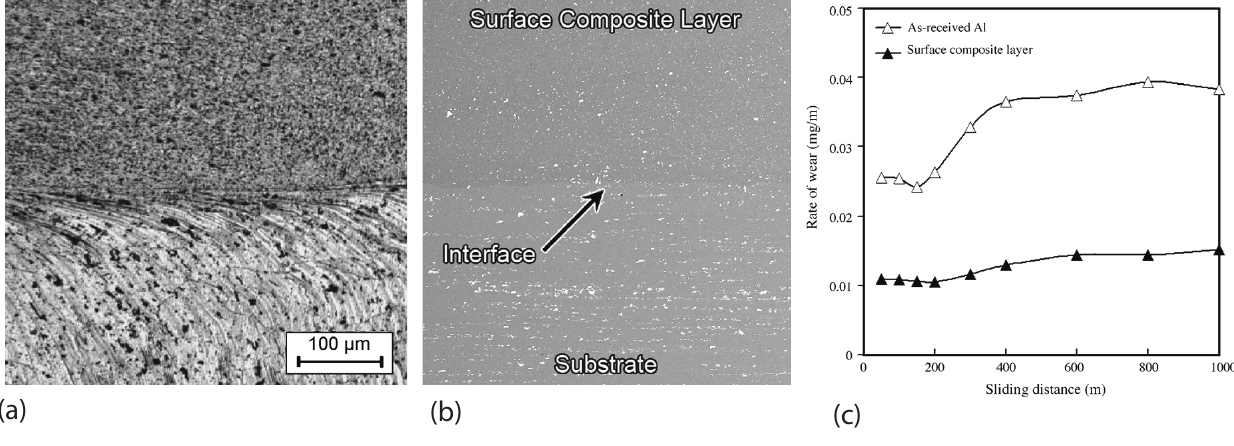
Figure 4 . Microstructure and wear property of friction stir processing alumina particle reinforced A6082 aluminum alloy (after Shafiei-Zarghani et al. [9]): (a) optical micrograph showing the composite top layer and the bottom layer of matrix alloy; (b) SEM image showing the well bonded interface between the two layers; (c) comparison of wear rate of the as-received alloy and the material with a surface nano-composite layer produced by four FSP